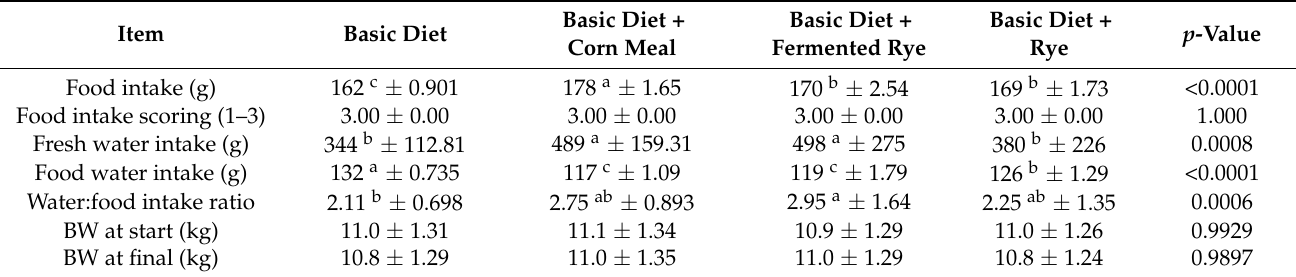
Table 4. Food intake on DM basis, food intake scoring, water intake and BW of dogs fed vegetarian diet (basic) and the experimental diets supplemented with hydrolyzed feather meal as well as either corn meal, fermented rye or rye (mean ± SD).